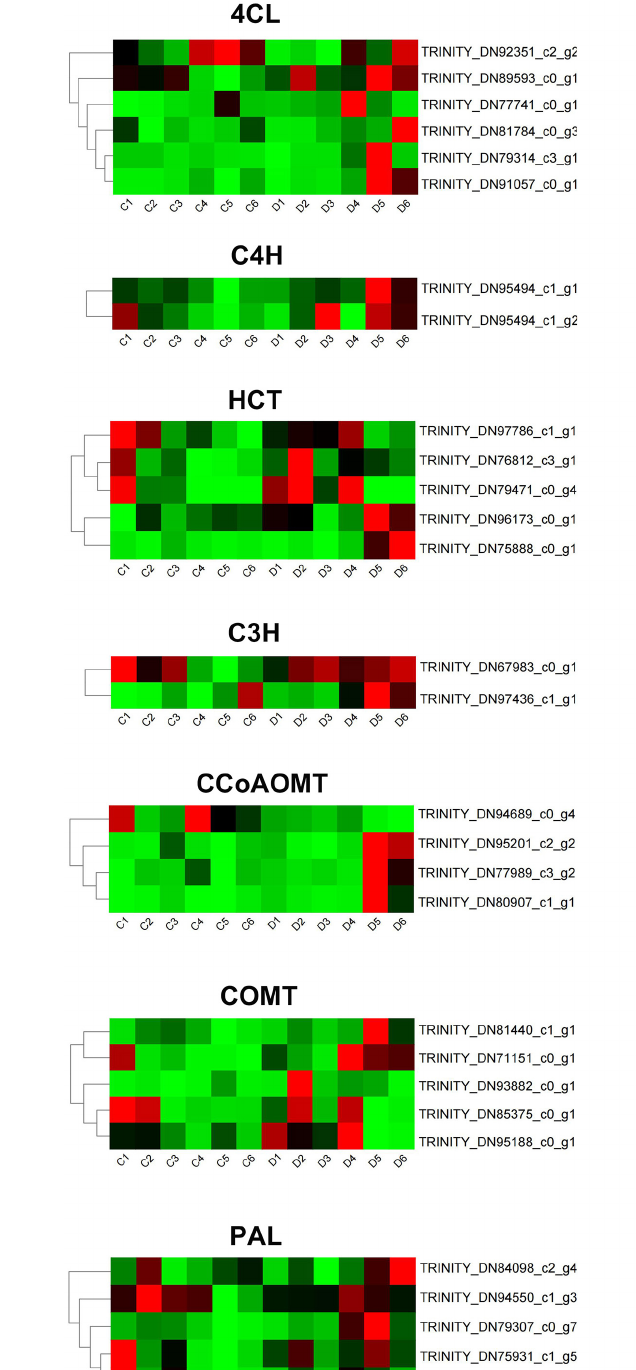
Frontiers in Plant Science |